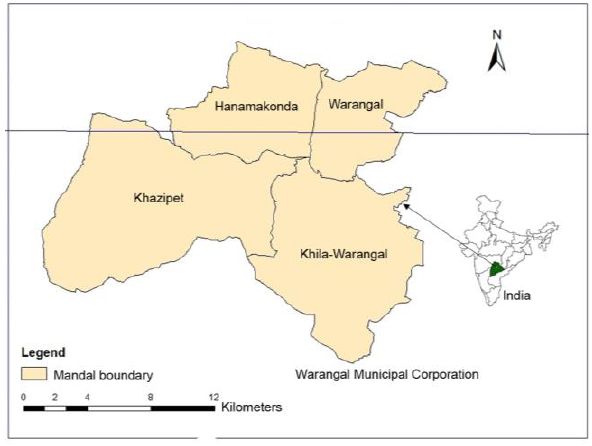
Fig. 1. Location map of the study area